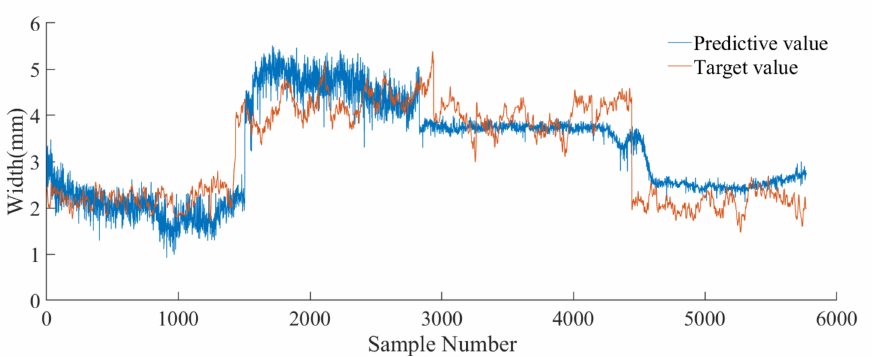
Figure 5. Comparison of measured data and predicted